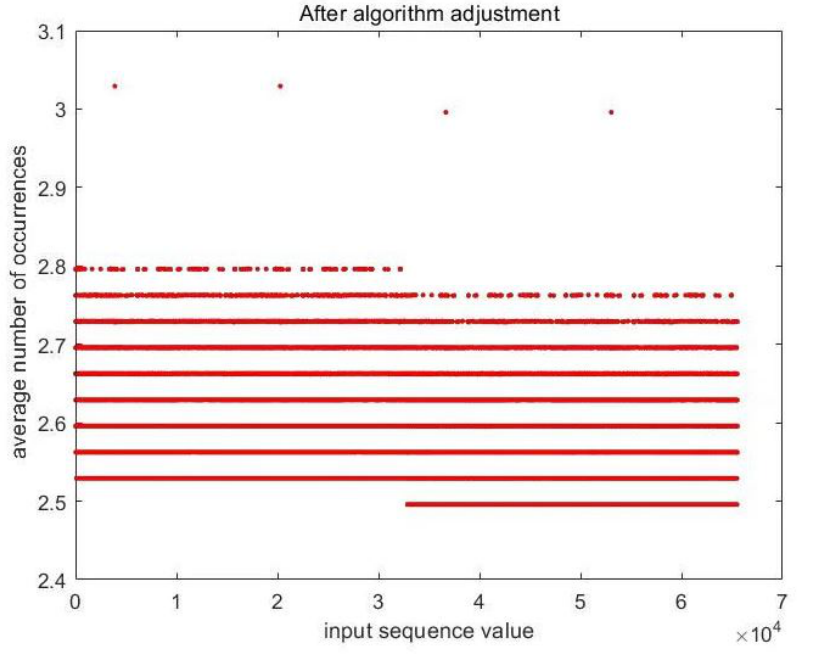
Figure 8. Mathematical expectation of the offset sequences in matrix A , in the 2000 left-shift operations. The horizontal axis is the value of the input sequence; the vertical axis is the mathematical expectation of the offset